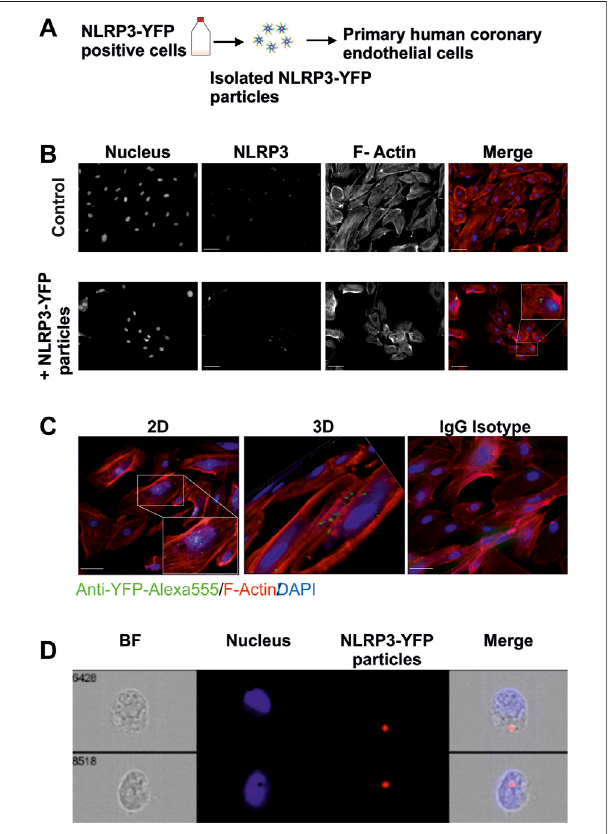
FIGURE 4 | Extracellular NLRP3-YFP particles are internalized by primary human coronary artery endothelial cells. (A) Schematic overview. Mutant NLRP3 (p.D303N)-YFP HEK cells are used to isolate oligomeric NLRP3-YFP in fl ammasome particles and treat primary human coronary arteryendothelialcells. (B) InternalizationofextracellularNLRP3-YFP particles in primary human coronary artery endothelial cells (HCAEC) after 4 h of incubation and determined by immuno fl uorescent staining (N = 3) with a primary fl uorescently labeled anti-YFP-Alexa555 antibody (green) (scale bar: 50 µm). Alexa Fluor ™ 647 Phalloidin (red) and DAPI (blue) were used for F-actinandnucleusstaining,respectively.Z-stackswithxzandyzfocalplanes showing internalized NLRP3-YFP in fl ammasome particle. (C) Z-stacks were used for 3D reconstruction (scale bar: 50 µm). (D) Two representative ImageStream ® analyses of HCAEC including bright fi eld (BF), DAPI (Nucleus), 647/Cy5 Channel (Ex. NLRP3), and a merge of an internalized extracellular NLRP3-YFP in fl ammasome are shown (scale bar: 10 µm).